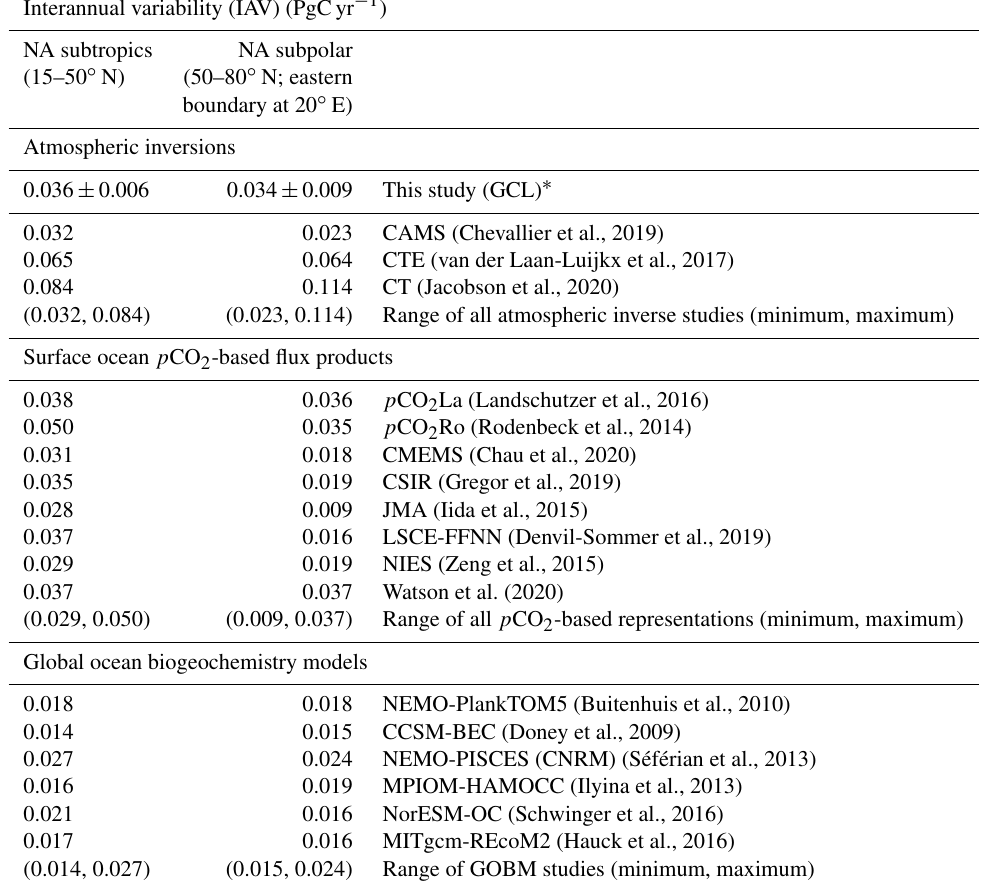
Table 3. Summary metrics of GEOS-Chem–LETKF North Atlantic (NA) CO 2 flux estimates and comparison with independent estimates (from atmospheric inverse analyses, surface p CO 2 mappings, and global ocean biogeochemistry models (GOBMs)) for the period 2000– 2017. Listed are estimates for the interannual variability of the regional fluxes over the period. The metrics listed in this table are plotted in Fig. 3c and